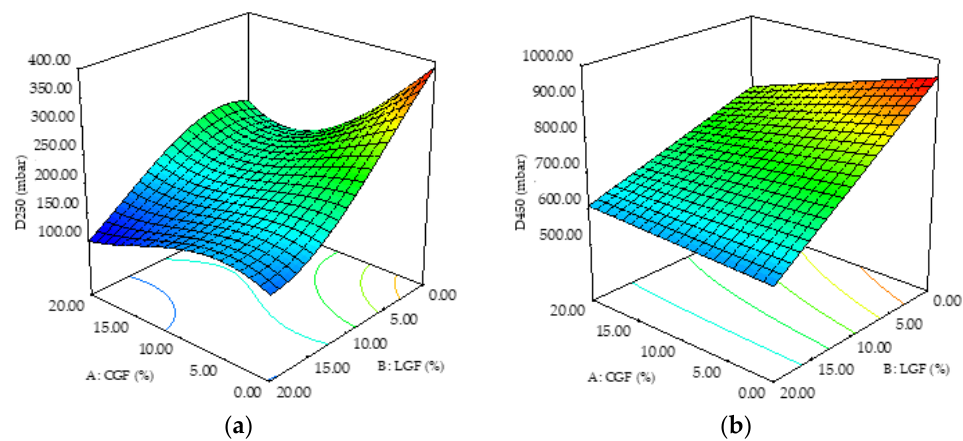
Figure 3. Response surface plot of ( a ) dough consistency after 250 s (D250) and ( b ) dough consistency after 450 s (D450) as a function of chickpea germinated flour (CGF) and lupin germinated flour (LGF) addition.